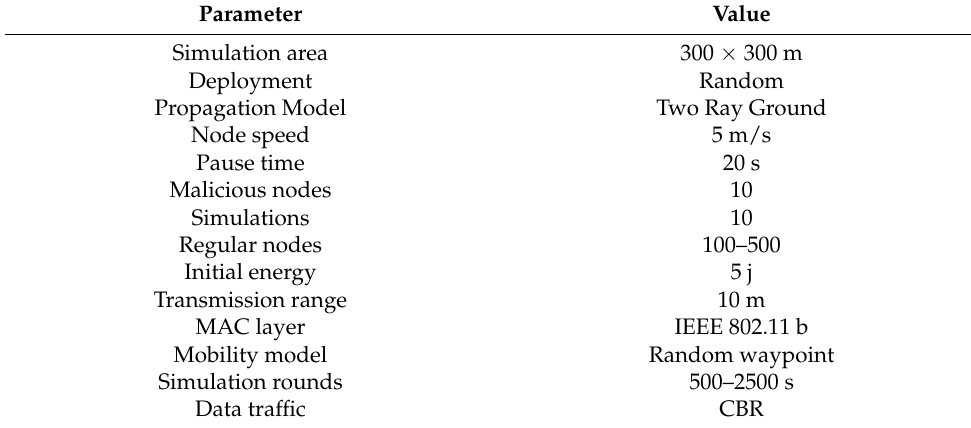
Table 3. Simulation configuration. Parameter